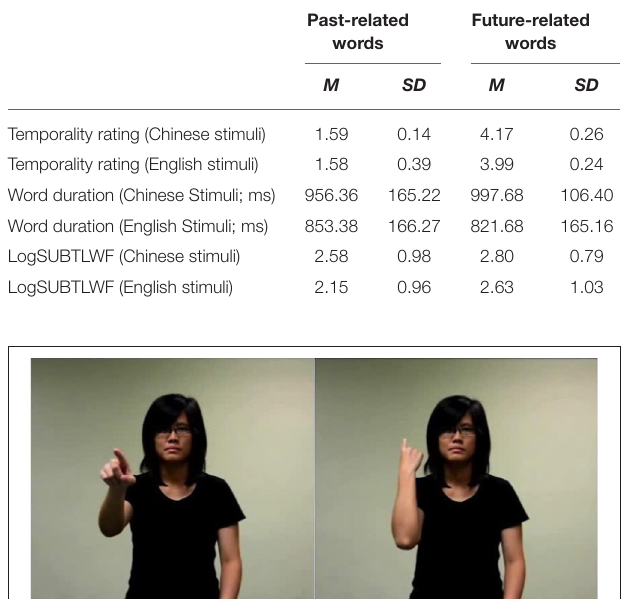
TABLE 1 | Mean temporal characteristics and duration of the past- and future-related words.